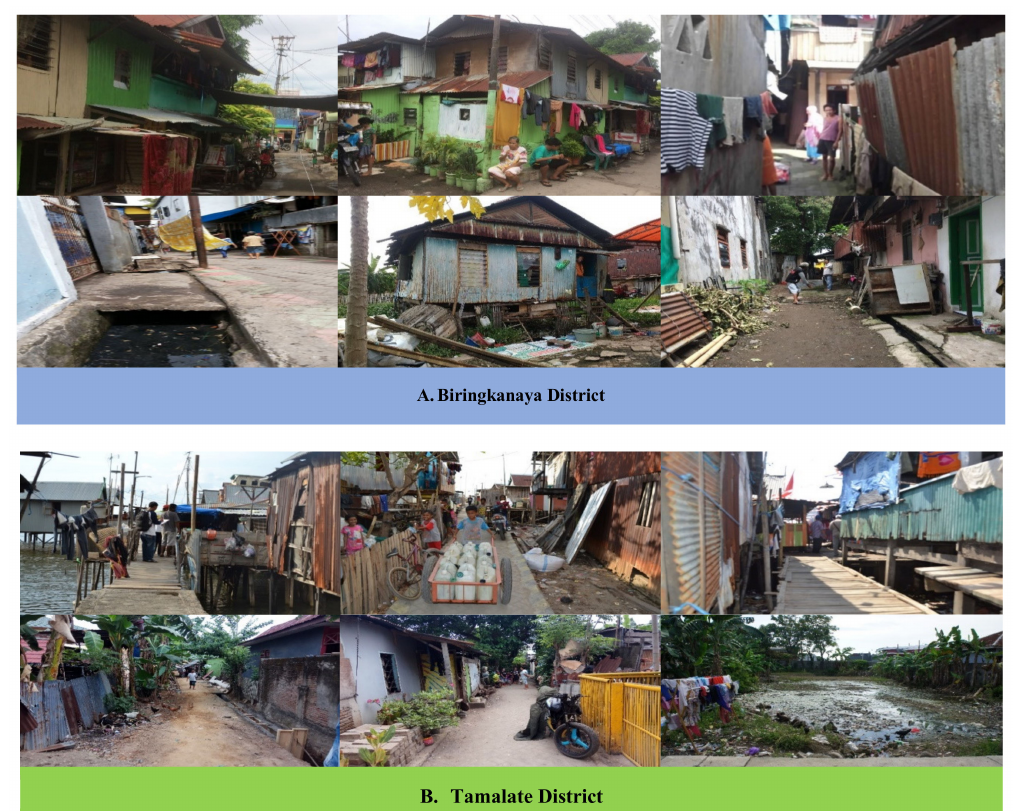
Figure 7. Examples of the conditions and characteristics of slums in ( A ) Biringkanaya and ( B ) Tamalate Districts in Makassar City. Source: Primary Data, 2019.